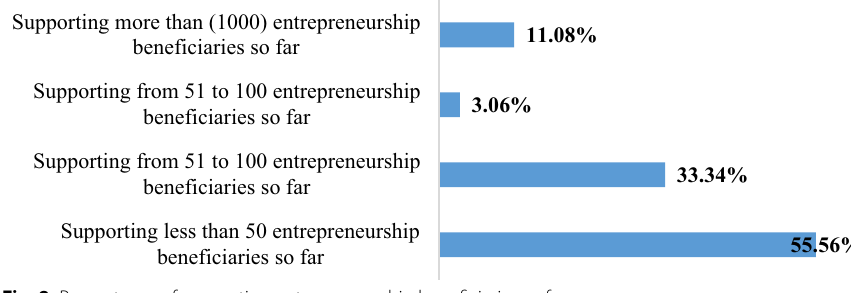
Fig. 8 Percentages of supporting entrepreneurship beneficiaries so far